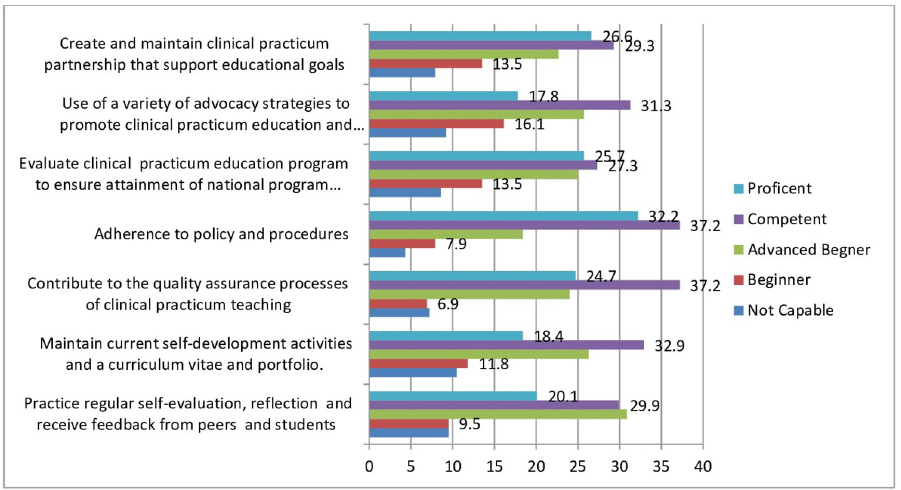
Fig 3. Clinical practicum teaching quality improvement and advocacy of preceptors for Medical Laboratory Science clinical practicum education programs in Ethiopia, 2021(N =